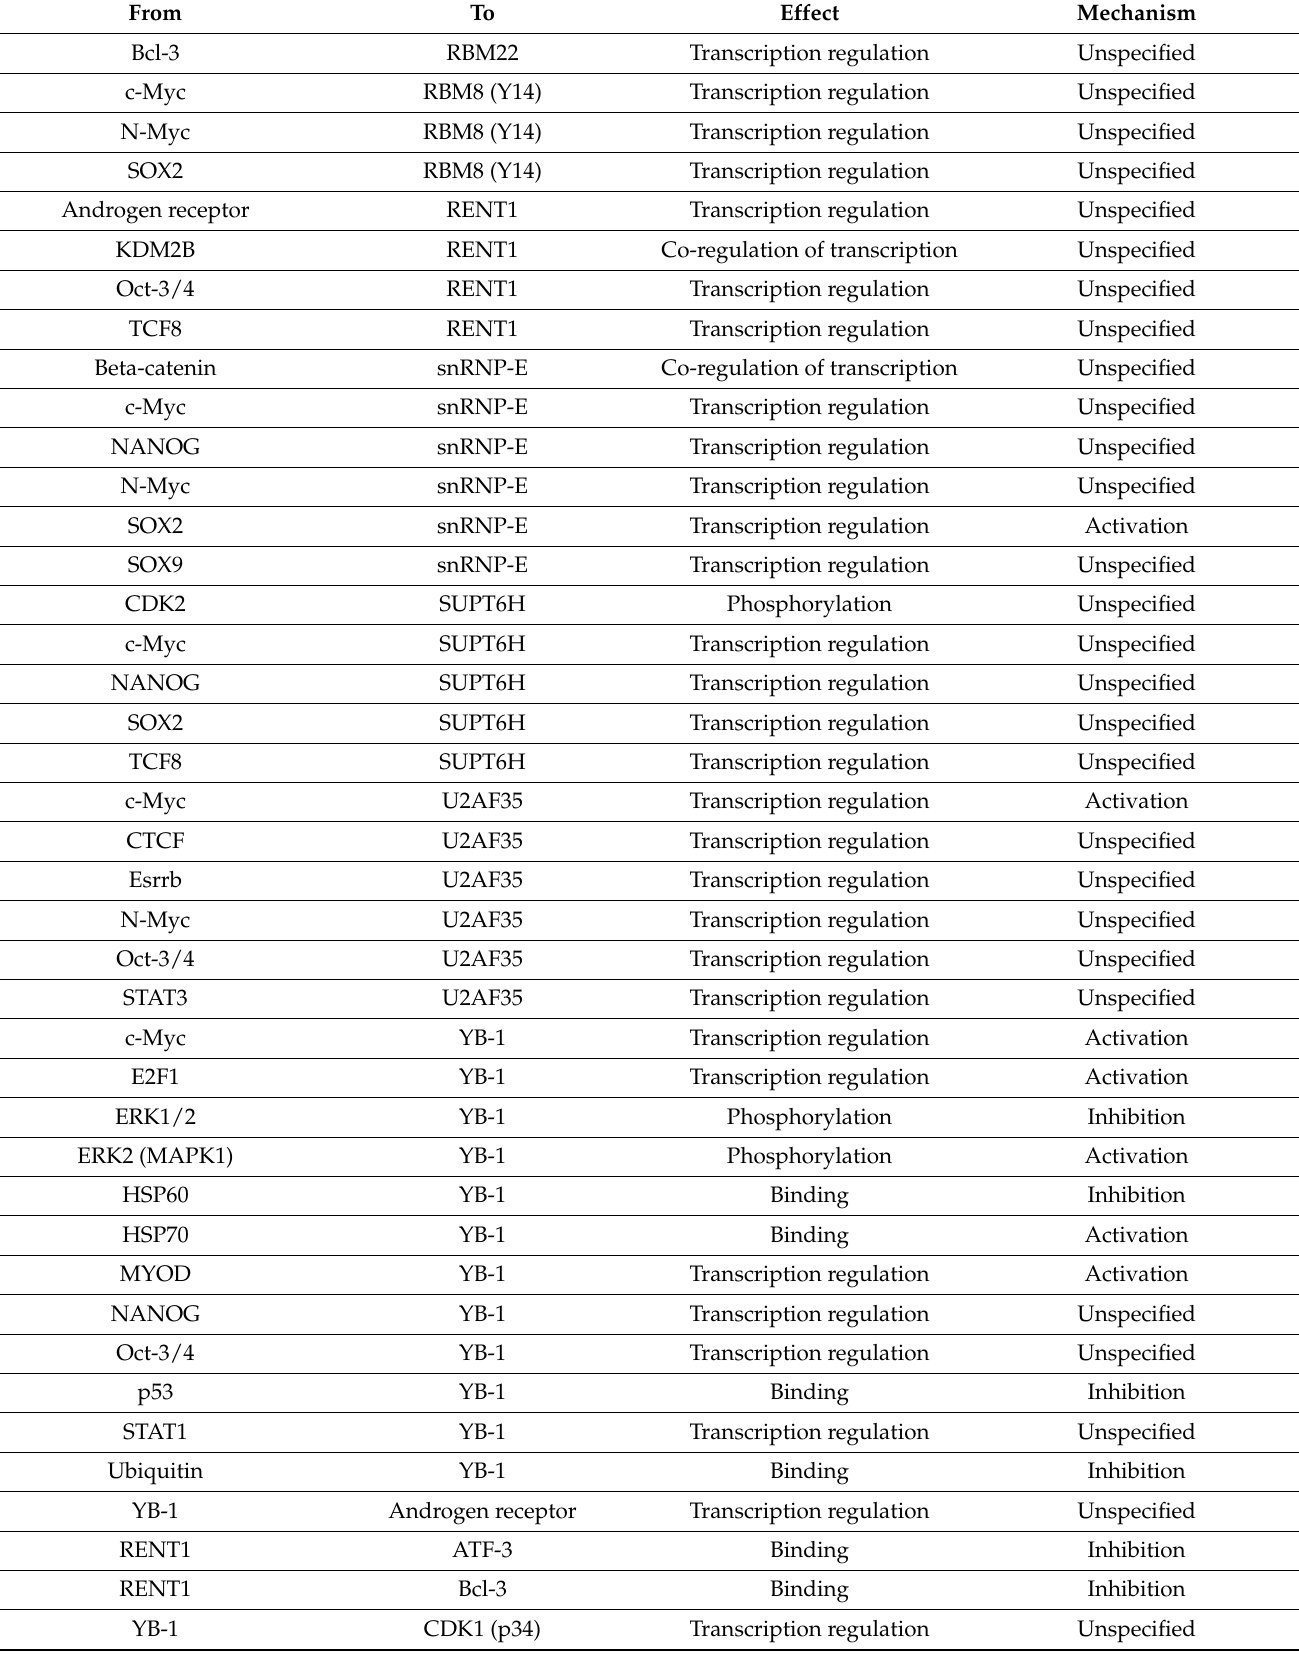
Table 4. The relationship of identified RBPs and transcriptional